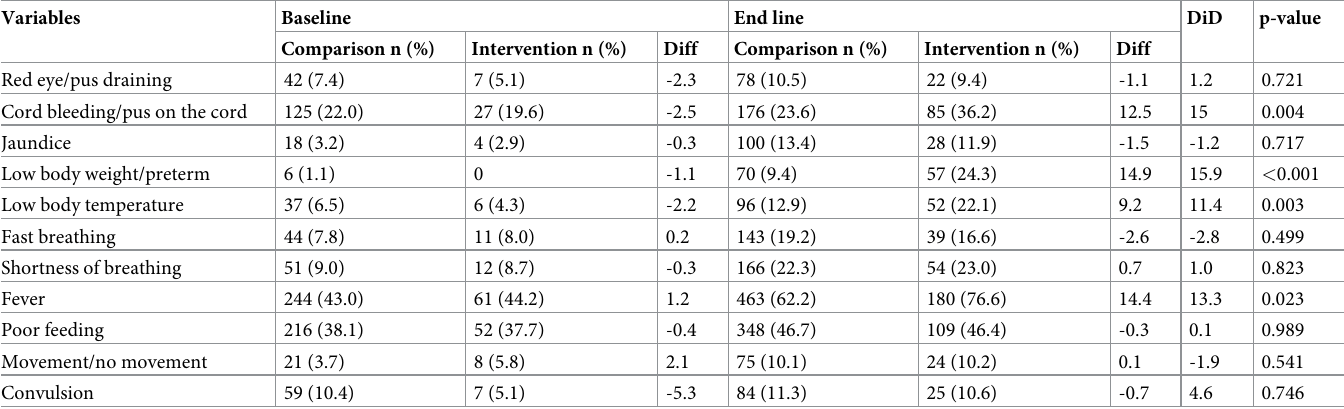
Table 5. Effect of the intervention on knowledge of neonatal danger signs.